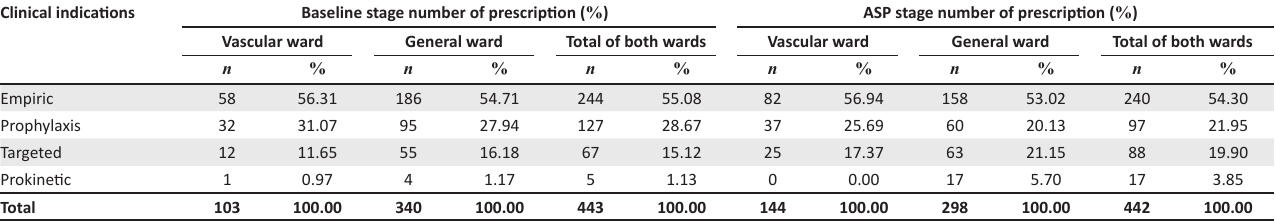
TABLE 1-A1: Antibiotic therapy based on clinical